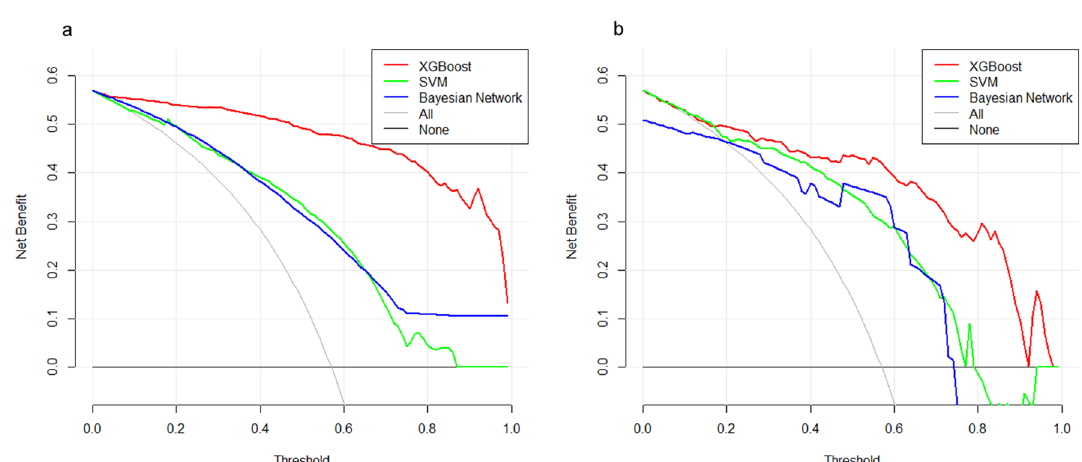
Figure 5. Decision curve analysis graph showing the net benefit against threshold probabilities based on decisions from model outputs. Three curves were based on predictions of the three different models, and the two curves were based on two kinds of extreme decisions. The curve called ‘All’ represents the prediction that all the patients would survive for 5 years, and the curve called ‘None’ represents the prediction that all the patients were dead at 5 years. ( a ) The training set, ( b ) the validation set. XGBoost, extreme gradient boosting; SVM, support vector machine. The figure was created by using R Version 3.4.4 (https ://www.r-proje